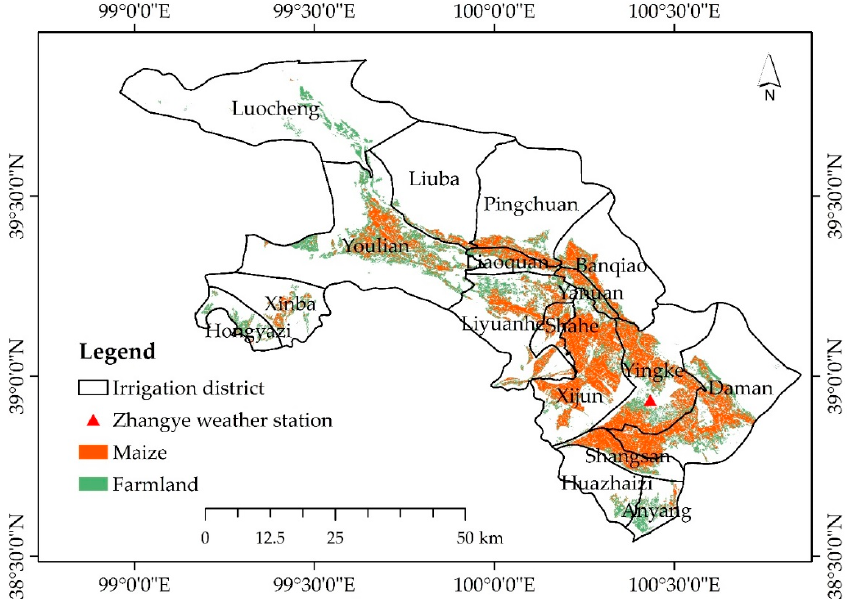
Agronomy 2020 , 10 , x FOR PEER REVIEW Figure 1. Geographic location of the study area and distribution of maize. Figure 1. Geographic location of the study area and distribution of maize.